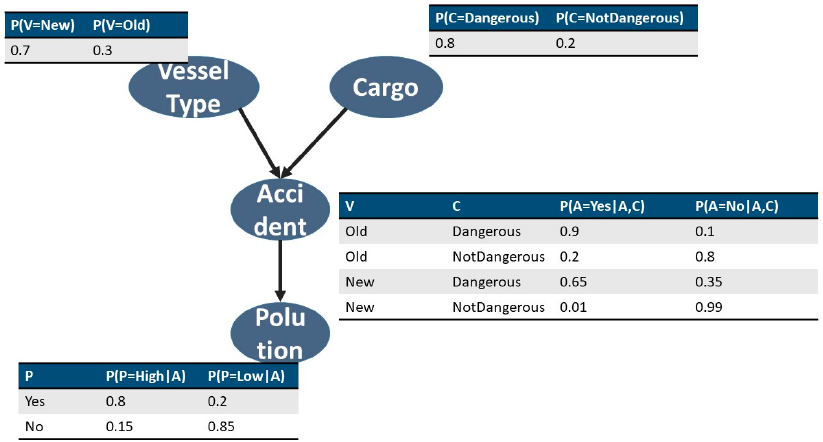
Figure 2. A toy Bayesian Network for marine traffic modeling.